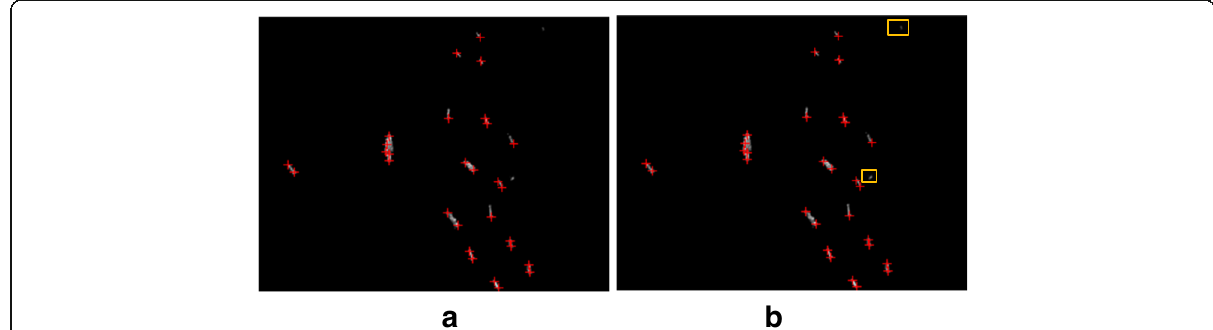
Fig. 7 The Harris detection result and false alarm target marking results. a Harris corner detection result. b The false alarm targets marking